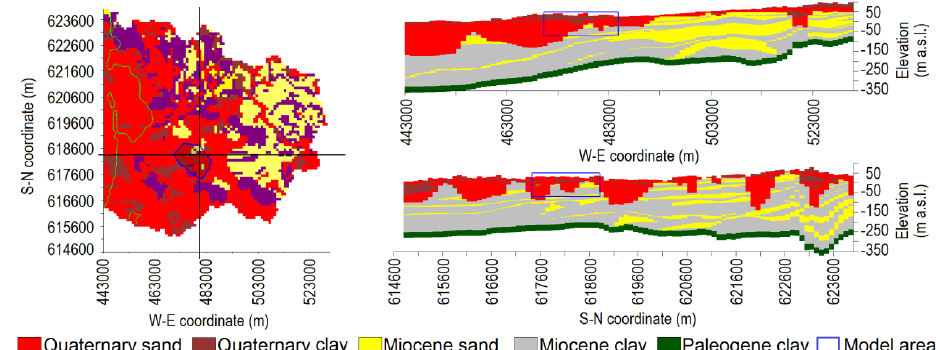
Figure 2. Regional geological structure, model area in this study is marked with a blue frame. The location is marked by the purple polygon in Fig. 1, and the horizontal plane is taken at 10ma.s.l. (modified after Scharling et al., 2009).